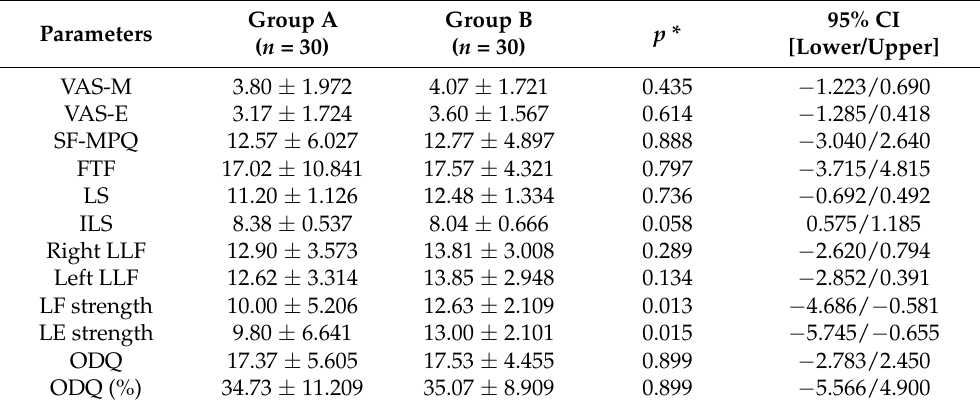
Table 2. Comparisons of the initial parameters between the two groups (confidence interval 95%) (mean ± SD). Group A Group B Parameters ( n = 30)